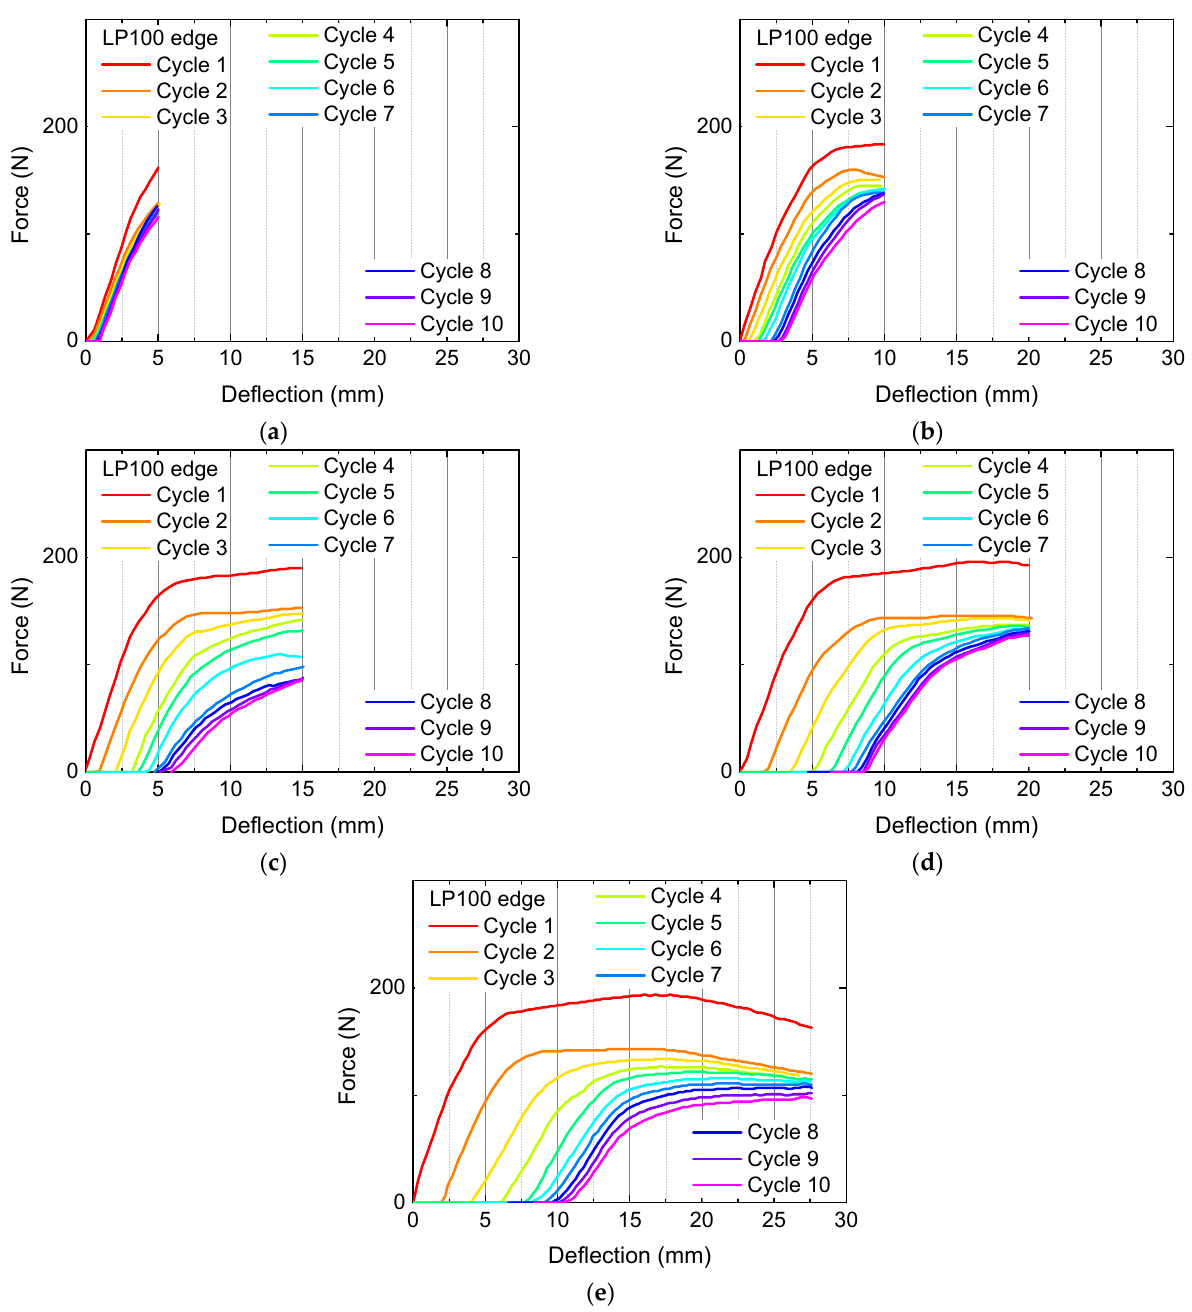
Figure 5. Bending and recovery tests of sample LP100, printed on the long edge, with different maximum deflections: ( a ) 5 mm; ( b ) 10 mm; ( c ) 15 mm; ( d ) 20 mm; and ( e ) 17.5 mm.